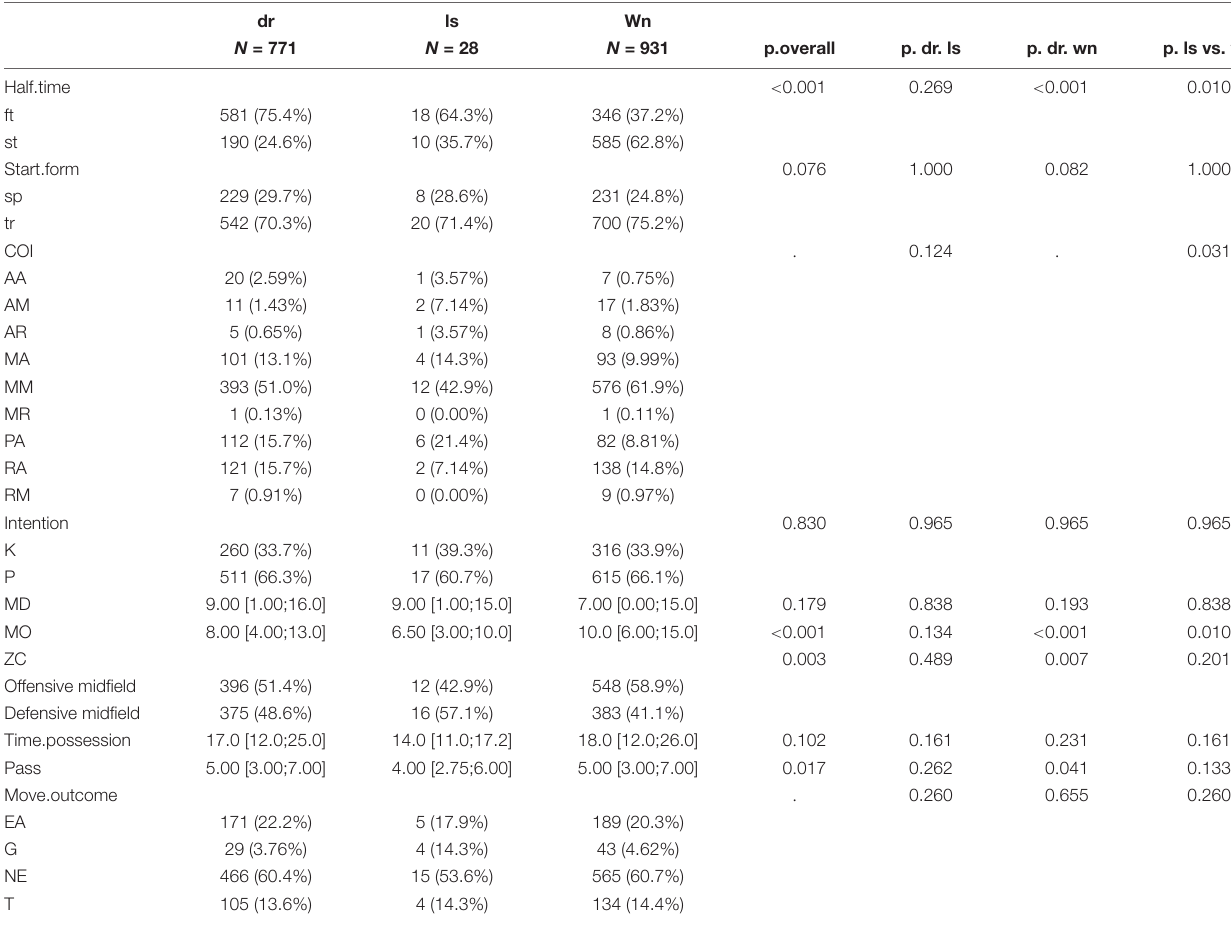
TABLE 5 | Bivariate descriptive summary with the variable “ Match.status ” as reference and the rest of the significant variables, in successful